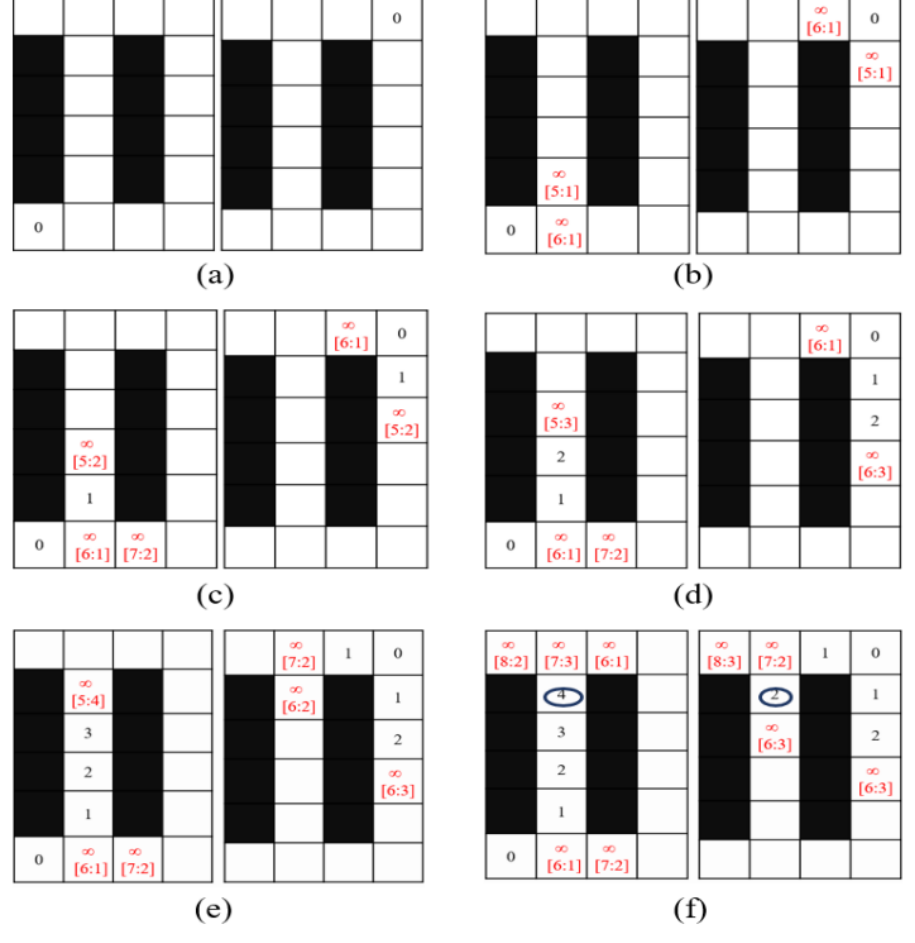
Figure 8. An illustration for bidirectional search BICA*.